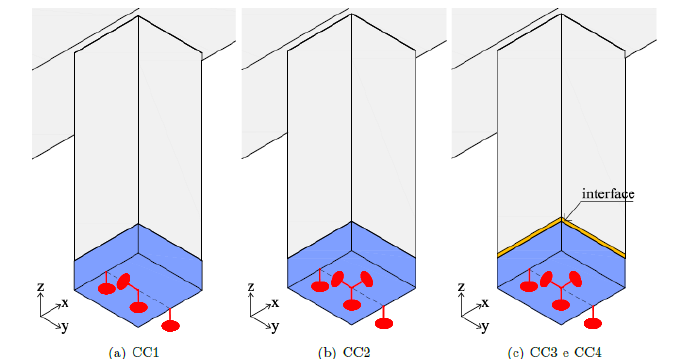
Figure 5. Boundary conditions at the base of the piles